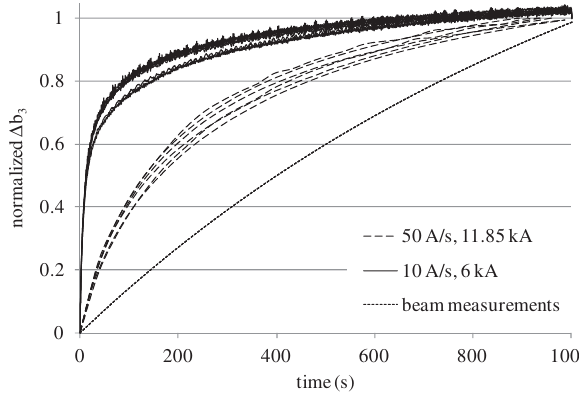
FIG. 7. Decay of b 3 for series measurements ( 50 A = s precycle and 11.85 kA flattop), in LHC operational condition of 2010–2011 ( 10 A = s and 6 kA flattop), and derived from beam